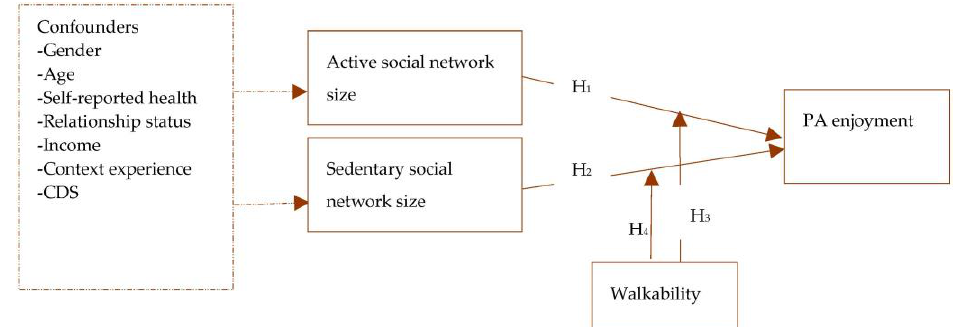
Figure 2. The association between active social networks, sedentary social networks, walkability, and PA enjoyment Note : Broken arrows represent potential confounding; CDS—chronic disease status; PA—physical activity; H 1 —active social network size is associated with PA enjoyment; H 2 —sedentary social network size is associated with PA enjoyment; H 3 —walkability moderates the association between active social network size and PA enjoyment; and H 4 —walkability moderates the association between sedentary social network size and PA enjoyment.